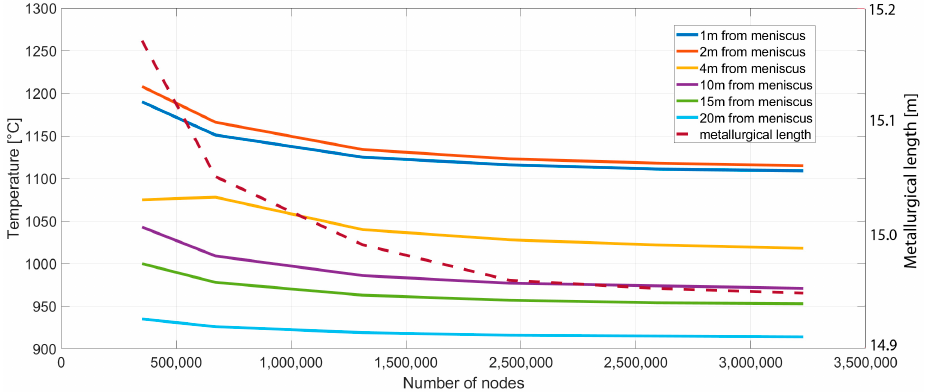
Figure 2. Temperatures and metallurgical length for different mesh densities.